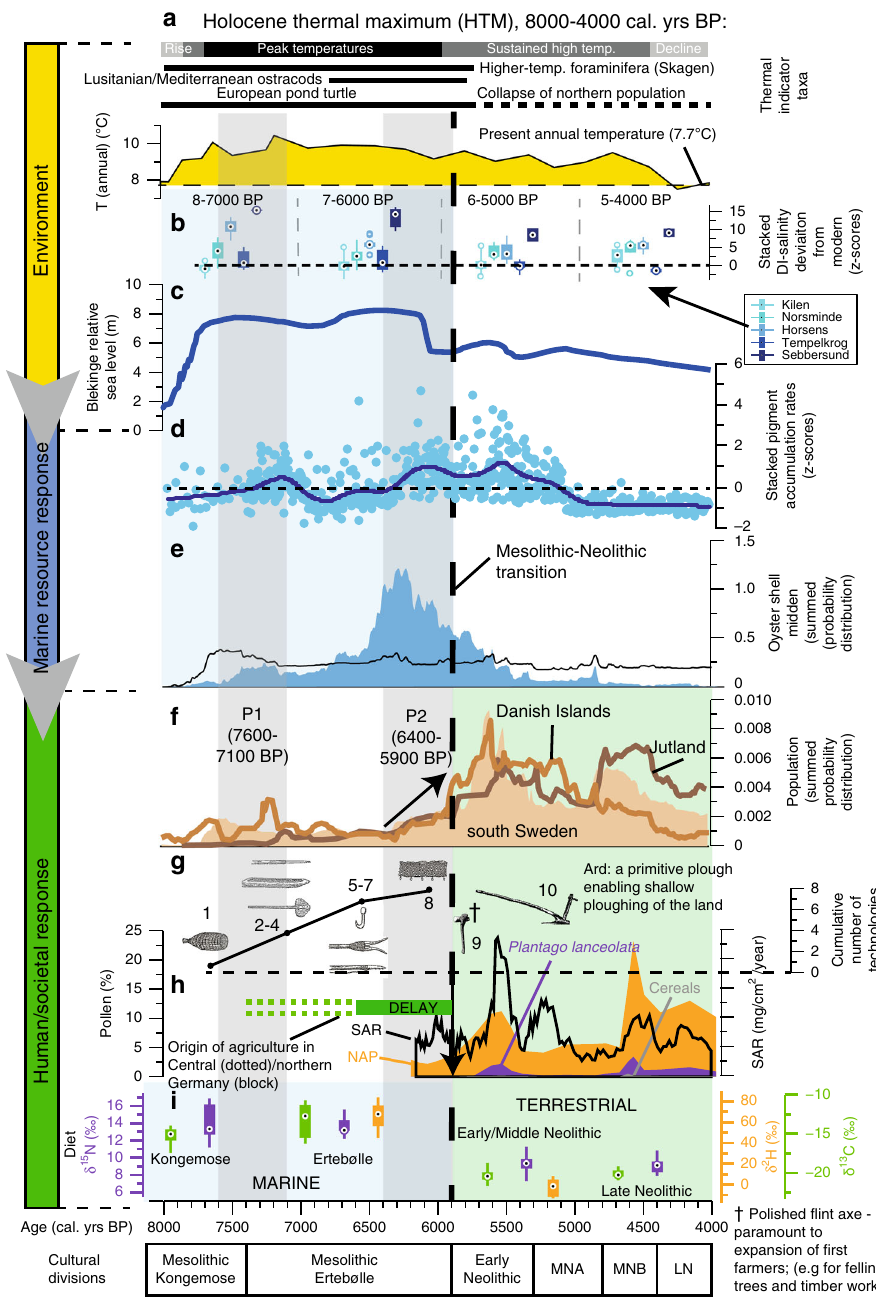
8Ard: a primitive plough enabling shallow ploughing of the